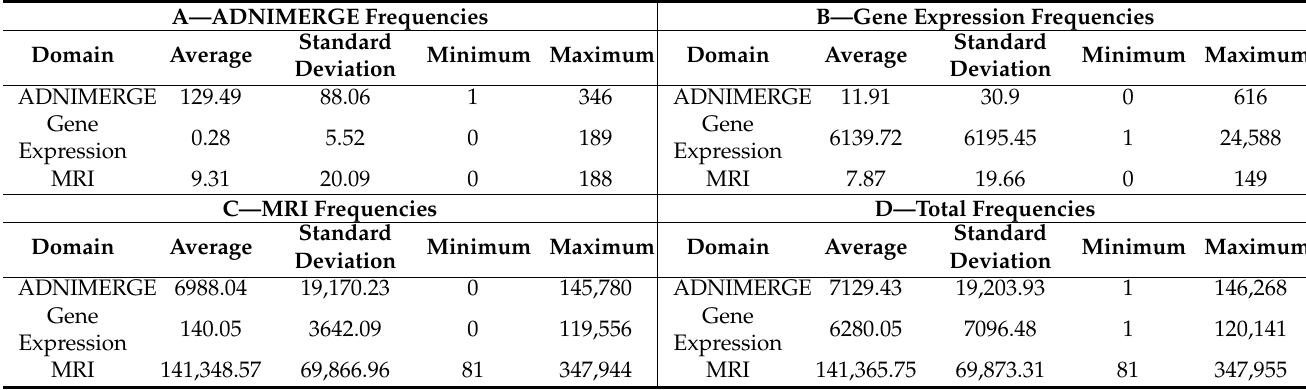
Table 3. Summarized correlated feature frequencies based on the Bonferroni corrected α